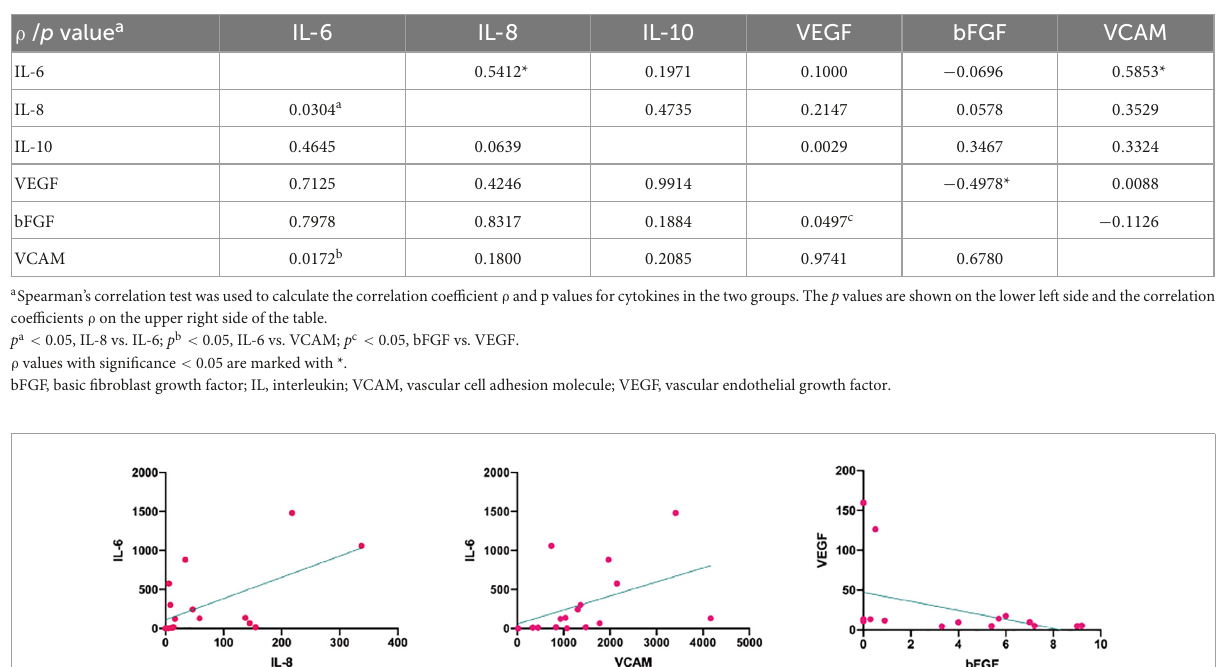
TABLE 4 Correlations between aqueous cytokines.